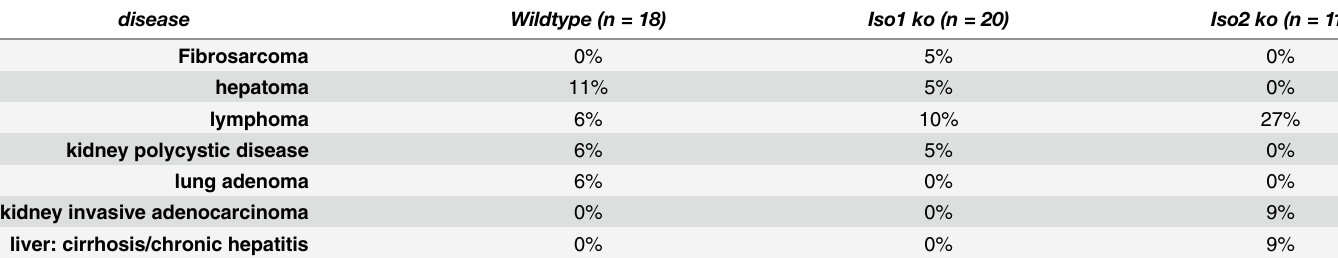
Table 4. Tumours observed in aged iso1 ko and iso2 ko